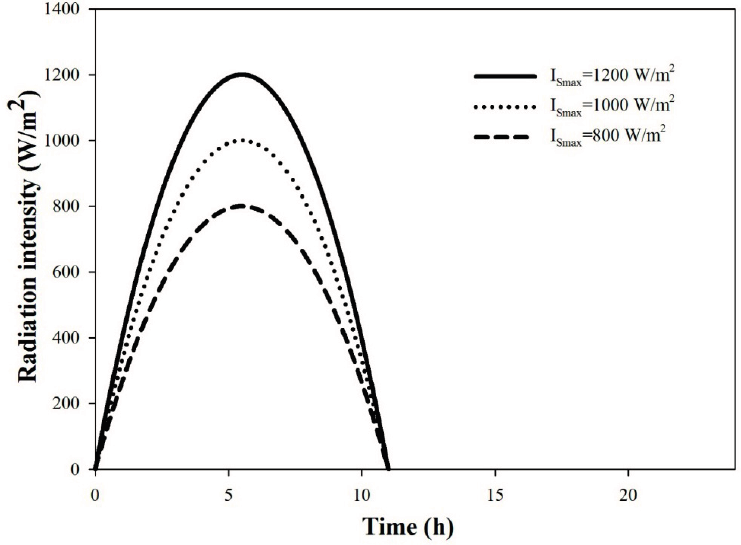
Figure 4. Solar radiation